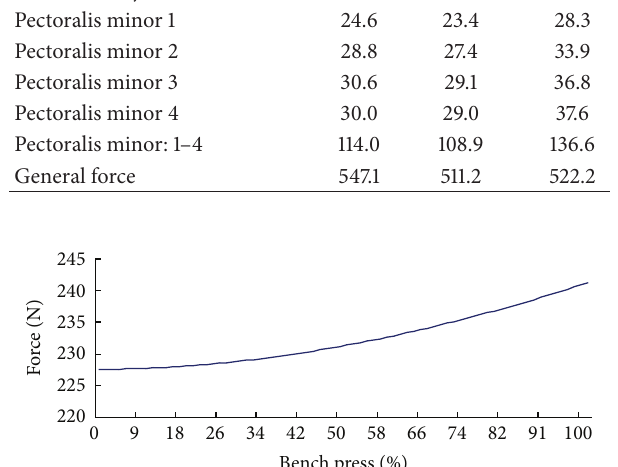
Figure 2: The change of the major pectoralis during bench presses.